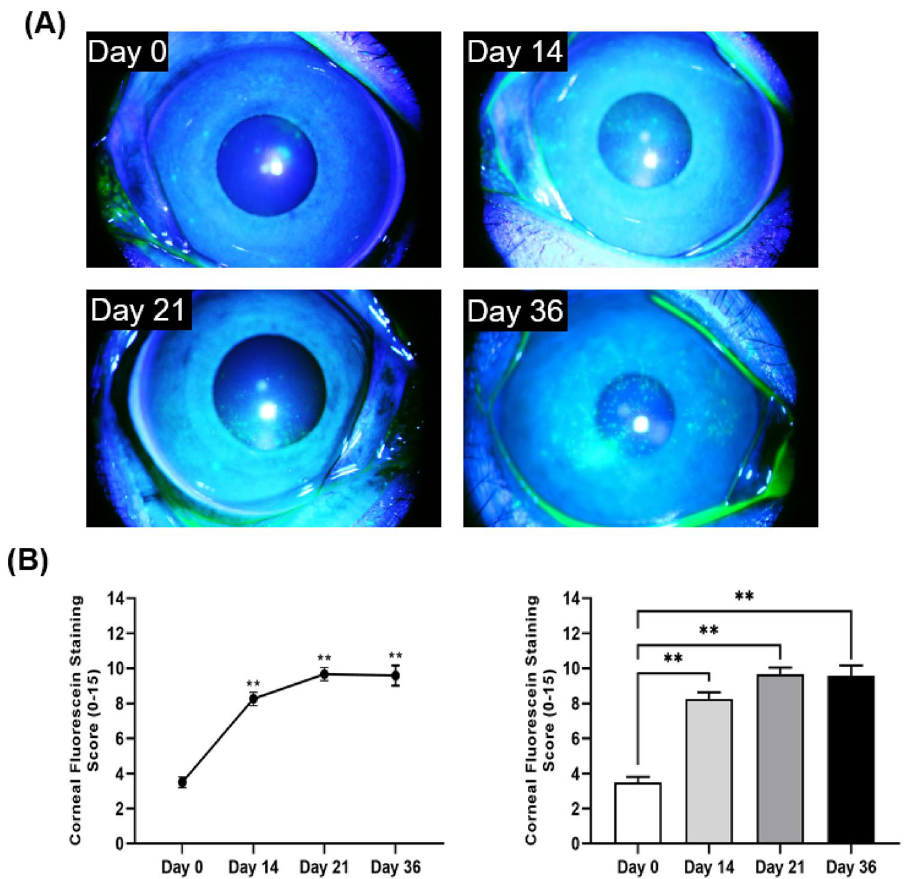
Figure 2. Corneal fluorescein staining of primate corneas. ( A ) Representative slit-lamp micrographs of fluorescein-stained corneas of monkeys housed in the controlled environment room on days 0, 14, 21, and 36. ( B ) Line graph (left) and bar chart (right) quantifying the corneal fluorescein score on indicated days post-dry eye induction. Representative data from two independent experiments are shown; each experiment consisted of 6 to 12 monkeys (n = 12–24 eyes/time point). Data are represented as mean ± SEM (error bar). T-test; * p < 0.05, ** p <